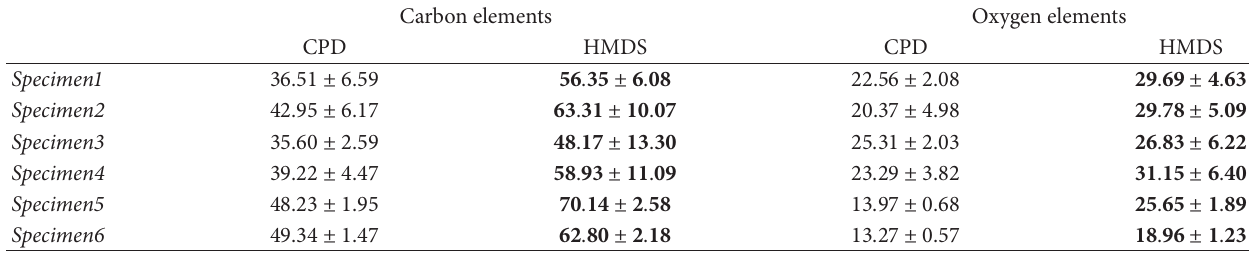
Table 3: Comparison of line-scanning EDX for carbon and oxygen elements of 10 captured cells for each specimen based on CPD and HMDS techniques in terms of